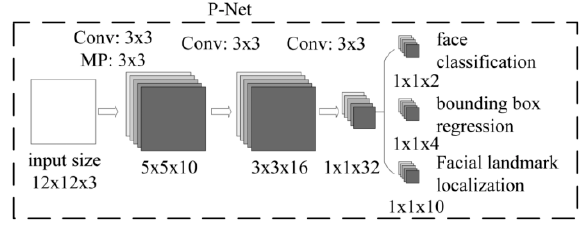
Figure 2. Proposal network (P-Net) structure.